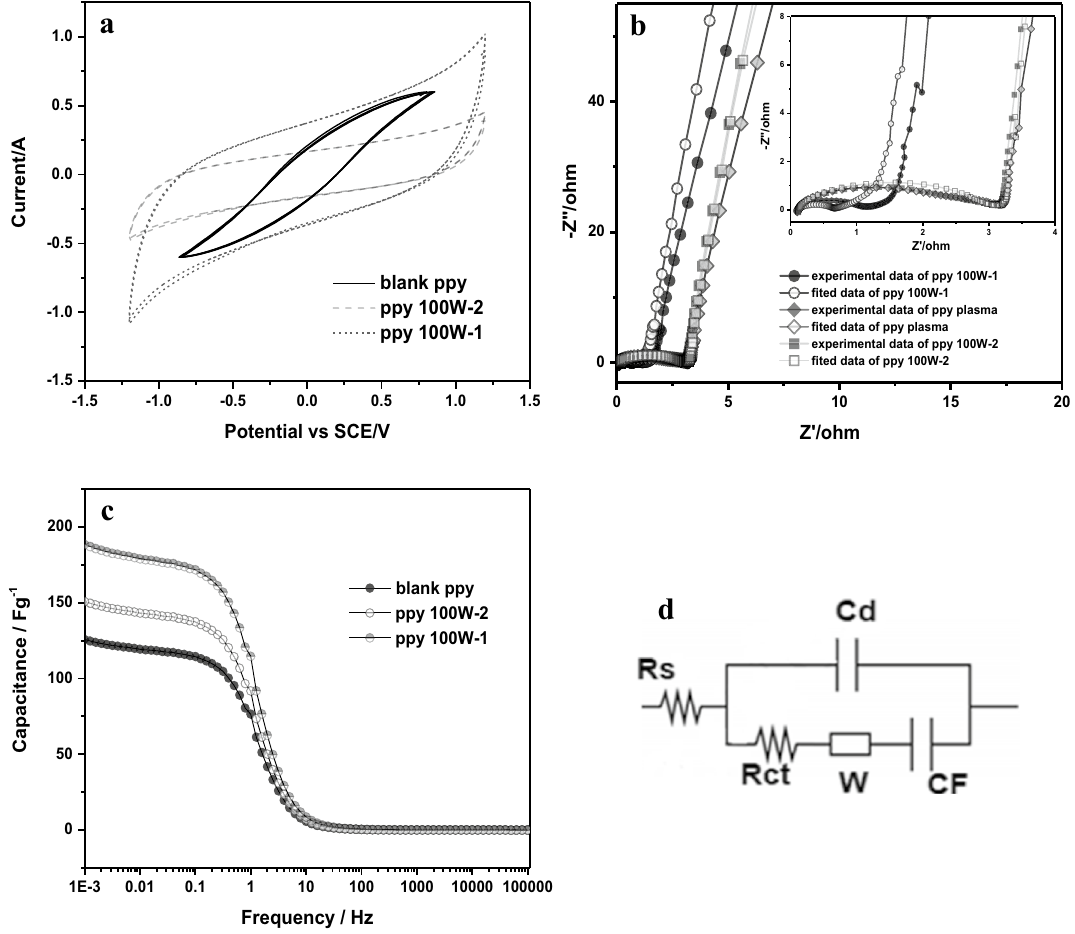
Fig. 6 a Cyclic voltammetry in 1 M KCl using ppy blank, ppy 100W-1 and ppy 100W-2 as work electrode at 5 mV s −1 scan rate. b Impedance Nyquist in 1 M KCl aqueous solution and fitted data, c Specific capacitance and d equivalent